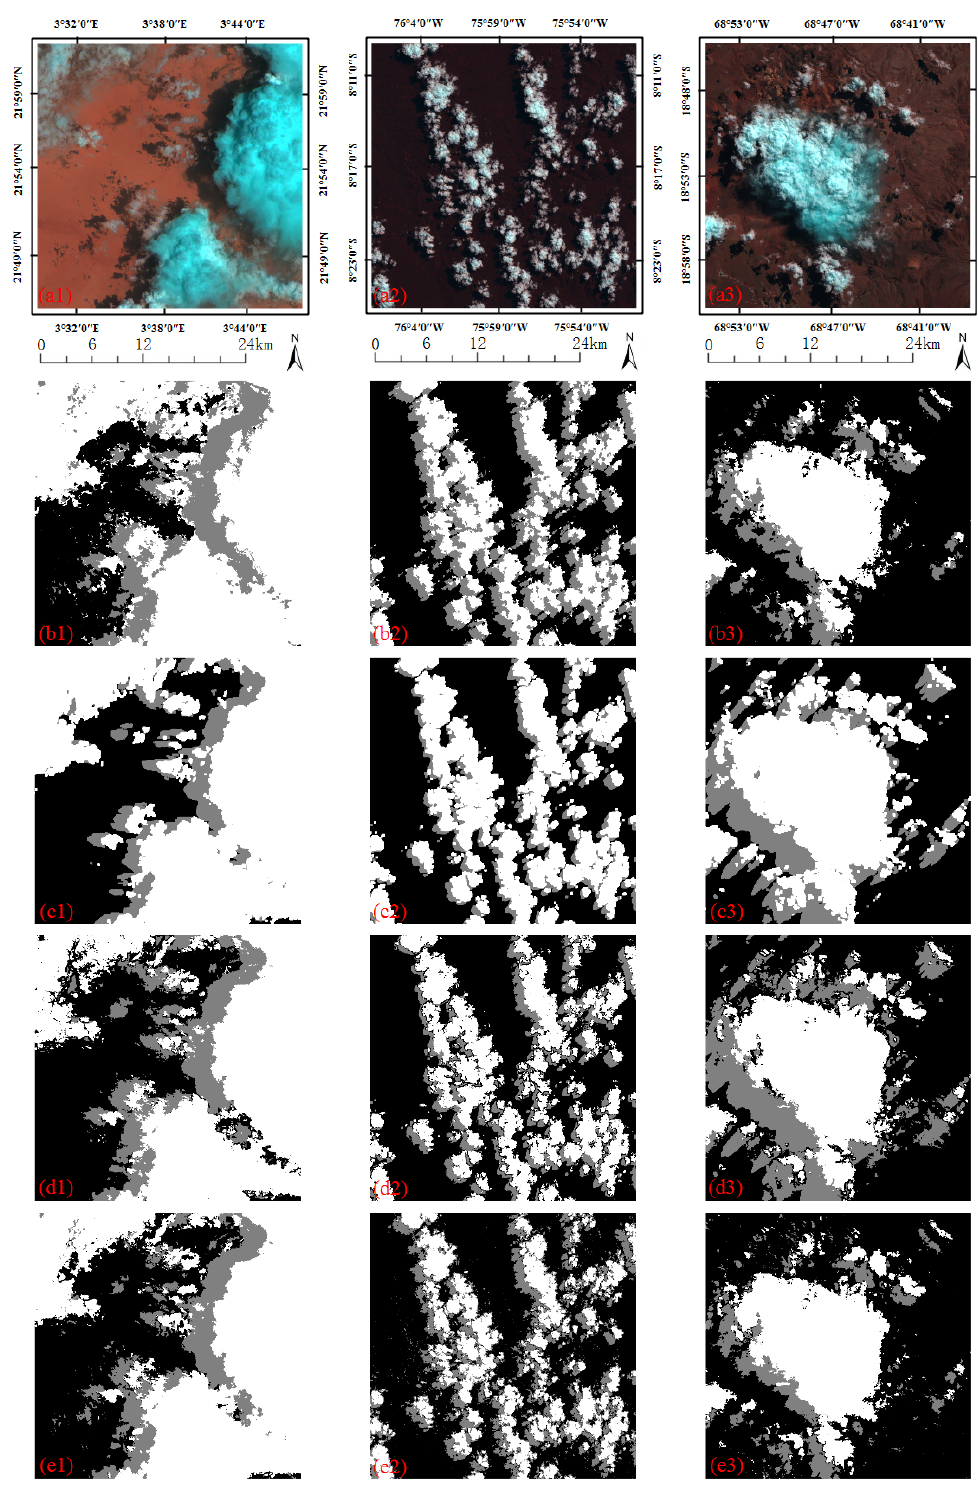
Figure 7. Visual comparisons of cloud and cloud shadow detection results of different methods. ( a1 – a3 ) Original color composite images ( a1 – a3 are subsets of Landsat 8 images LC81930452013126LGN01, LC80070662014234LGN00 and LC80010732013109LGN00, respectively). ( b1 – b3 ) Ground truth (white represents the cloud, gray represents the cloud shadow and black represents the non-cloud). ( c1 – c3 ) Zhu’s method. ( d1 – d3 ) Li’s method. ( e1 – e3 ) The proposed